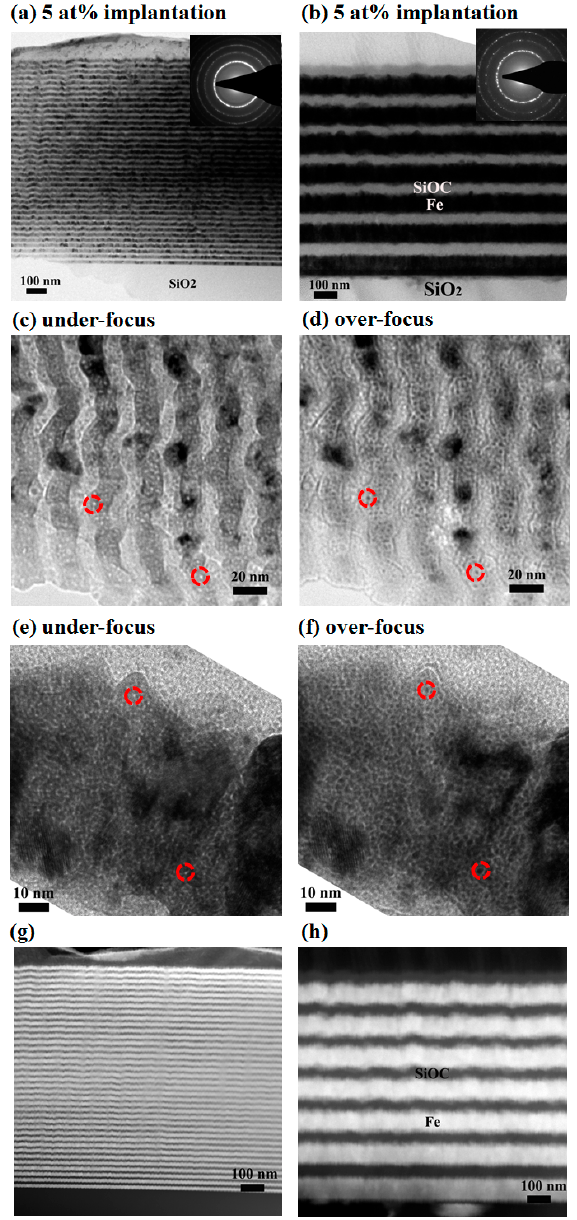
Figure 3. The typical cross-sectional TEM images of ( a ) thin, ( b ) thick Fe/SiOC multilayers after 5 at% He implantation. The He peak damage regions of thin and thick Fe/SiOC multilayers are taken at under-focus ( − 400 nm) and over-focus (+400 nm) condition, respectively, shown as ( c ), ( d ), ( e ), ( f ). The corresponding scanning transmission electron microscopy (STEM) images are present as ( g ) and ( h ), respectively.